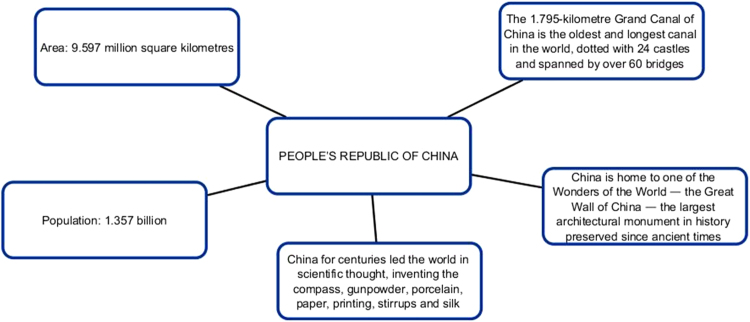
Infographics “People's Republic of China” [1].